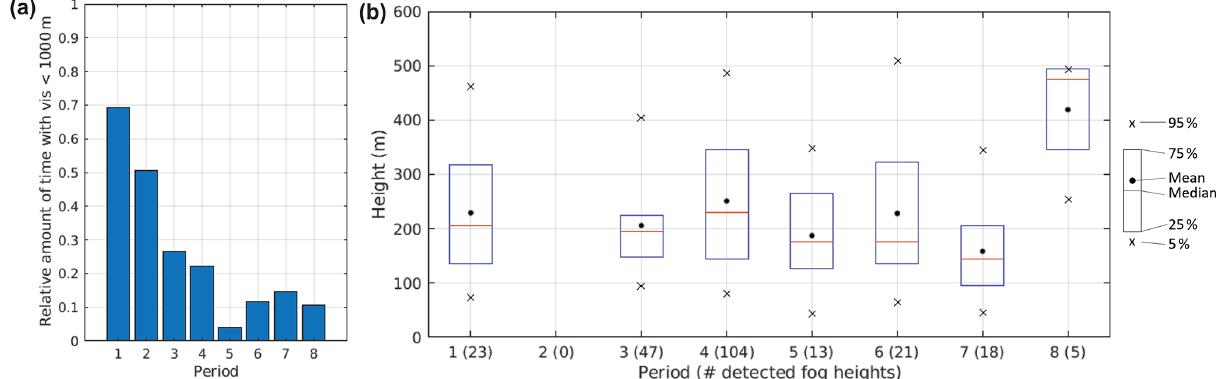
Figure 18. Fog statistics. Relative amount of time with visibility < 1000m for each period and statistics of fog depths for each period where data were available (in period 2 no radar data were